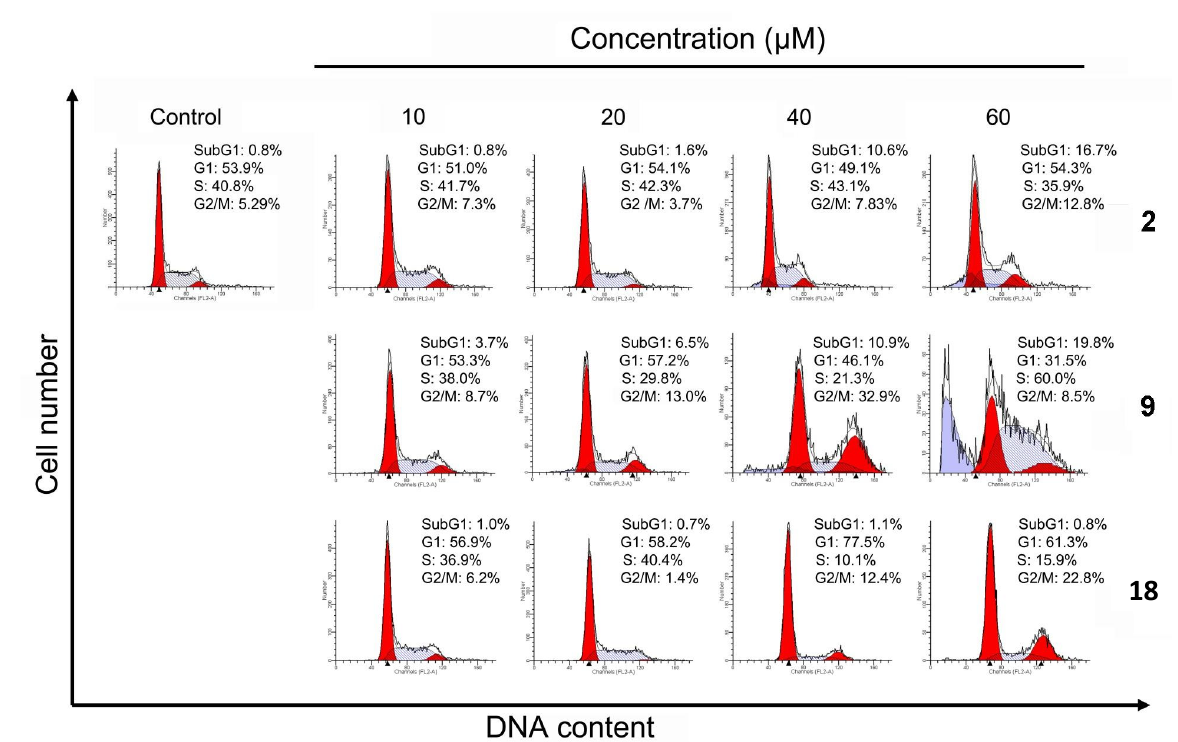
Figure 3. Induction of cells arrest by norcantharidin ( 2 ), compounds 9 and 18 . Effects of different concentrations of norcantharidin ( 2 ), compounds 9 and 18 on cell-cycle progression of HepG2 cells. HepG2 cells were untreated or treated with 10–60 μ M norcantharidin ( 2 ), compounds 9 and 18 for 48 h. After treatment, cells were fixed and stained with PI, and the cell cycle distribution was examined by flow